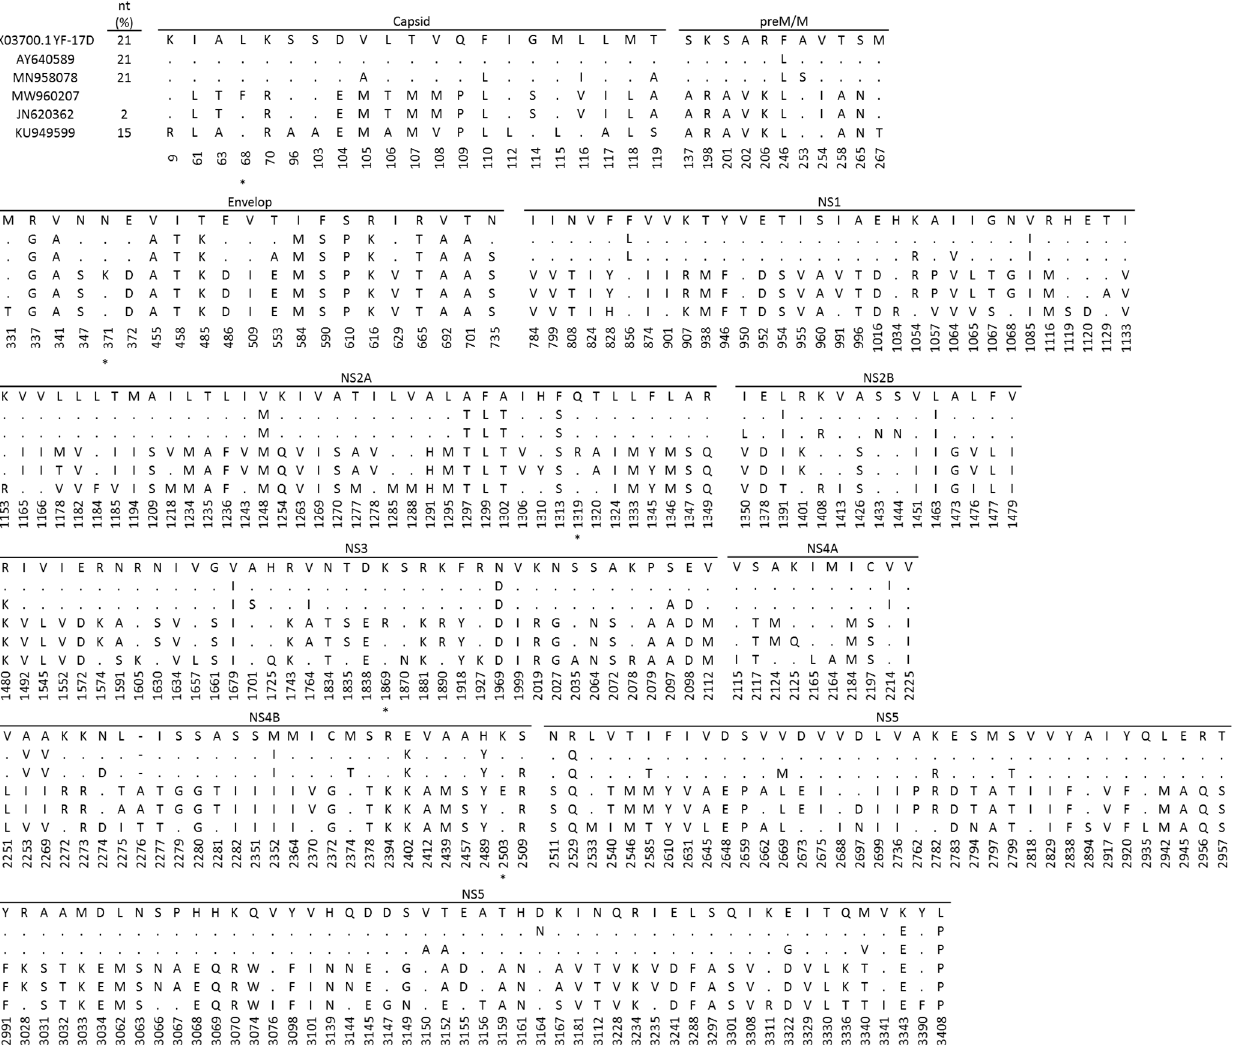
Figure 2. Pairwise comparison of the full-length yellow-fever virus polyprotein from CAR. Amino- acid mutations are represented by the one-letter code and conserved residues are represented by dots. Unique amino-acid changes present in the studied strain are shown by an asterisk (*). nt (%) represent the distance between our sequence and the other strain. X03700.1 YF-17D yellow-fever vaccine strain, MW960207 is the strain described in this study.